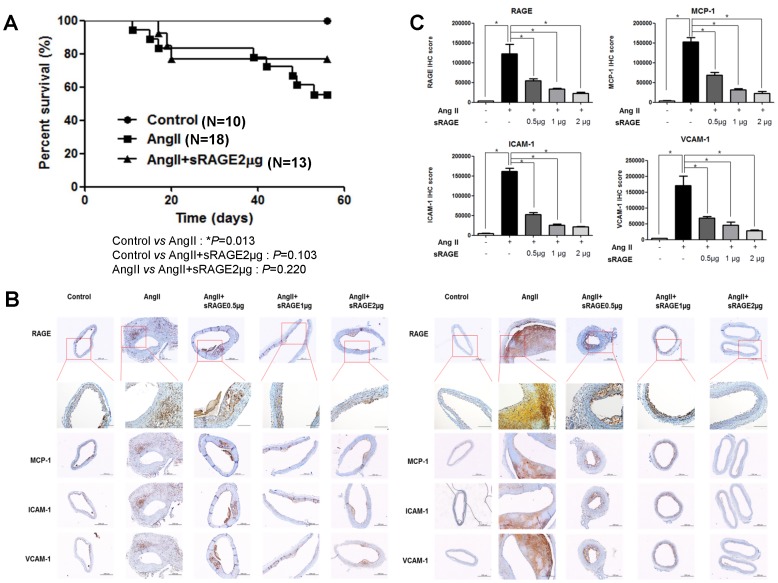
Survival and Development of Atherosclerotic Lesions in Apo E KO mice with AngII-induced atherosclerosis.A. Survival graph of Angiotensin II-induced atherosclerosis in Apo E KO mice with saline injection, AngII-infused, and AngII with sRAGE-treated groups. B. Immunohistochemistry sections of aorta (left =  ascending aorta, right =  infrarenal abdominal aorta) staining for inflammation markers (RAGE, ICAM-1, VCAM-1, and MCP-1) from Apo E KO mice saline injection and AngII-induced atherosclerotic Apo E KO mice (magnification: x10 and below RAGE data: x20). C. Decreased intensity in atherosclerotic areas of sRAGE-treated AngII-induced Apo E KO mice compared to AngII-induced Apo E KO mice (n = 7). The positive stain is expressed in arbitrary units normalized against a control. *p<0.01, Scale bar = 200 µm.